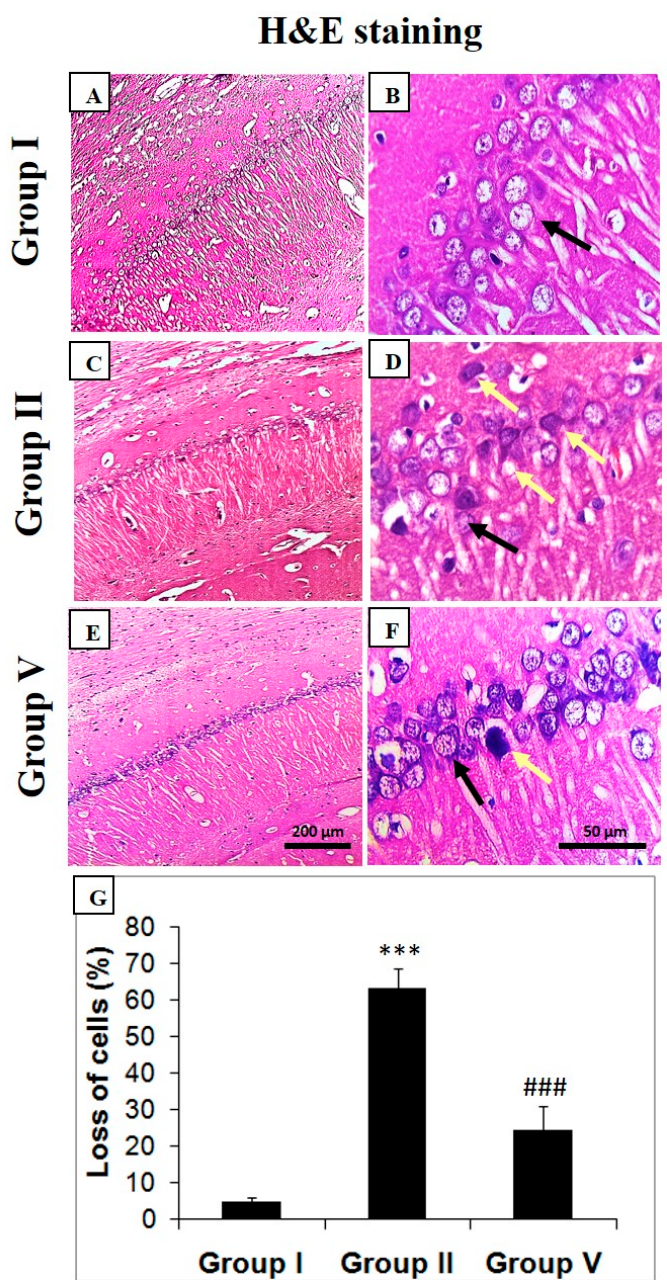
Figure 3. Zingerone effects on histomorphological features in LiCl-and-pilocarpine-induced SE. There is normal histology of group I ( A , B ) with intact and appropriately sized nuclei and neural cells. In group II ( C , D ) there is distortion of neurons along with neural condensation and necrosis, pyknotic nuclei in pilocarpine-administered rats as compared to negative control mice. Group V ( E , F ) treatment of zingerone (50 mg/kg) recovered the damage which was evident by retaining of normal histology and decrease in neural distortion and death. Values are expressed as mean ± SEM ( n = 6). Photomicrographs of hippocampus depicting Hematoxylin and eosin staining analyses. Below photomicrographs is the panel which shows quantitative evaluation of neural loss. Significant difference was indicated by *** p < 0.001 when compared with group I and ( ### p < 0.001) when compared with group II. Zingerone treatment significantly protected neural loss in group V ( ### p < 0.001) when compared with group II ( G ). Group I: Normal saline (10 mL/kg b.w.), Group II: LiCl (3 mEq/kg b.w.) + pilocarpine (30 mg/kg b.w.), Group V: zingerone (50 mg/kg b.w.) + LiCl (3 mEq/kg b.w.) + pilocarpine (30 mg/kg